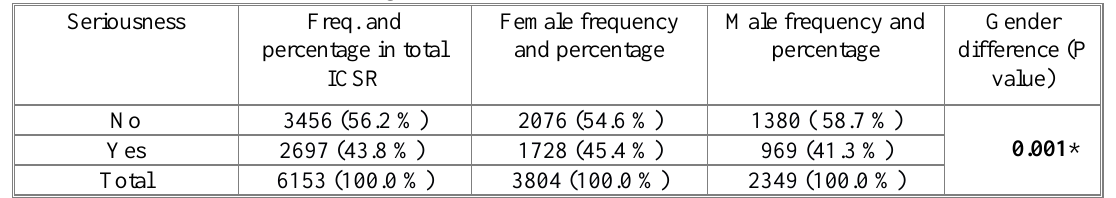
Seriousness Freq.